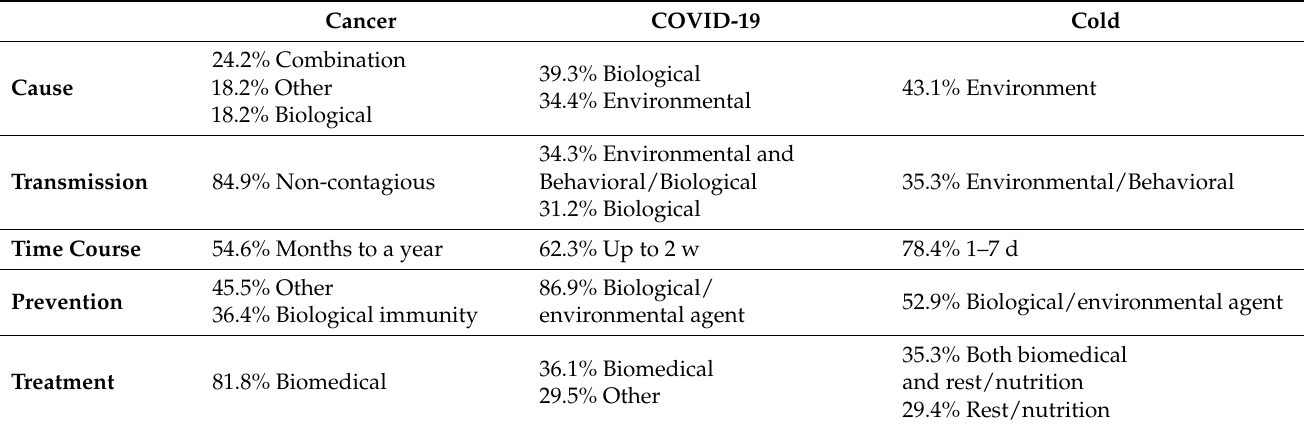
Table 1. Most common response category for each illness dimension by